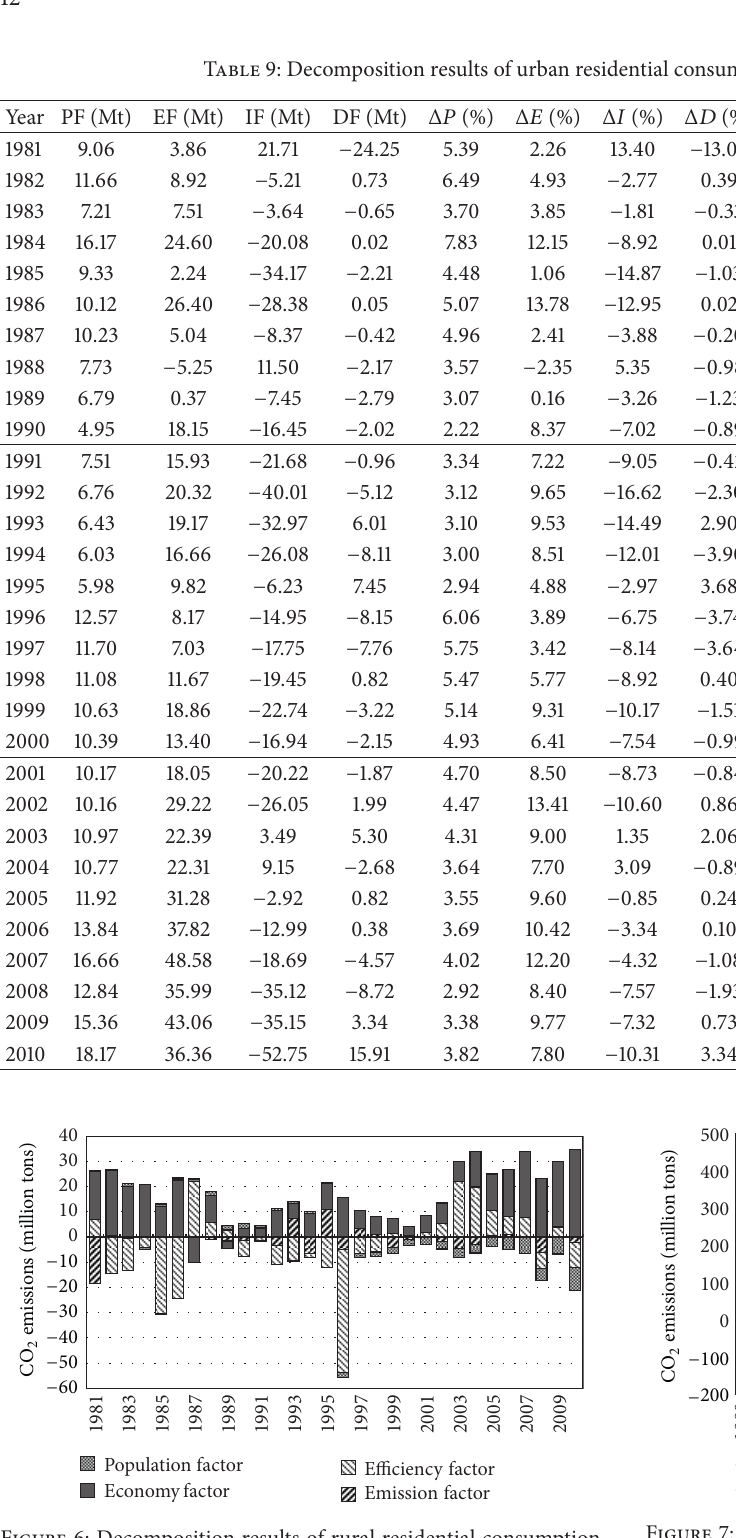
Figure 6: Decomposition results of rural residential consumption CO 2 emissions (1981–2010).